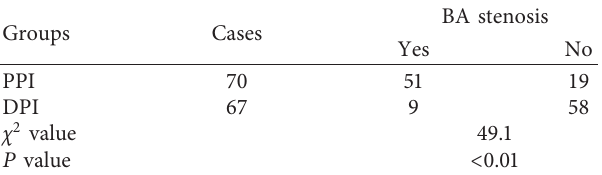
Table 5: Binary logistic analysis of the relationship between PPI, CV of systolic pressure, diastolic pressure, and the poor outcome at 3